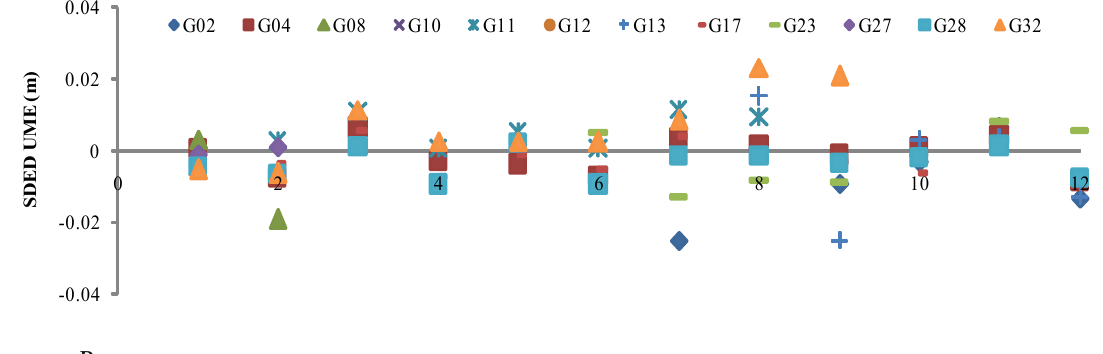
Figure 5. Satellite- and epoch differenced un-modeled